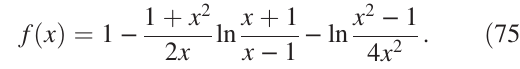
FIG. 9. Bounds on extractable work as a function of θ , as derived from only modularity constraints [in green, Eq. (74)], a combination of modularity þ symmetry constraints [in orange, Eq. (76)], and only symmetry constraints [in blue, Eq.